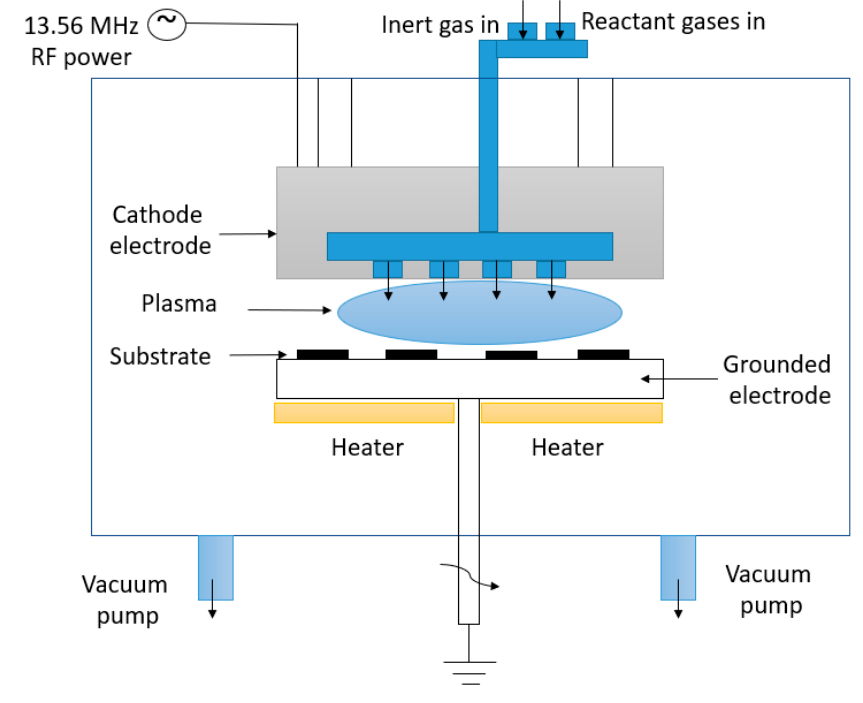
Figure 5. Working principle of the PECVD process.